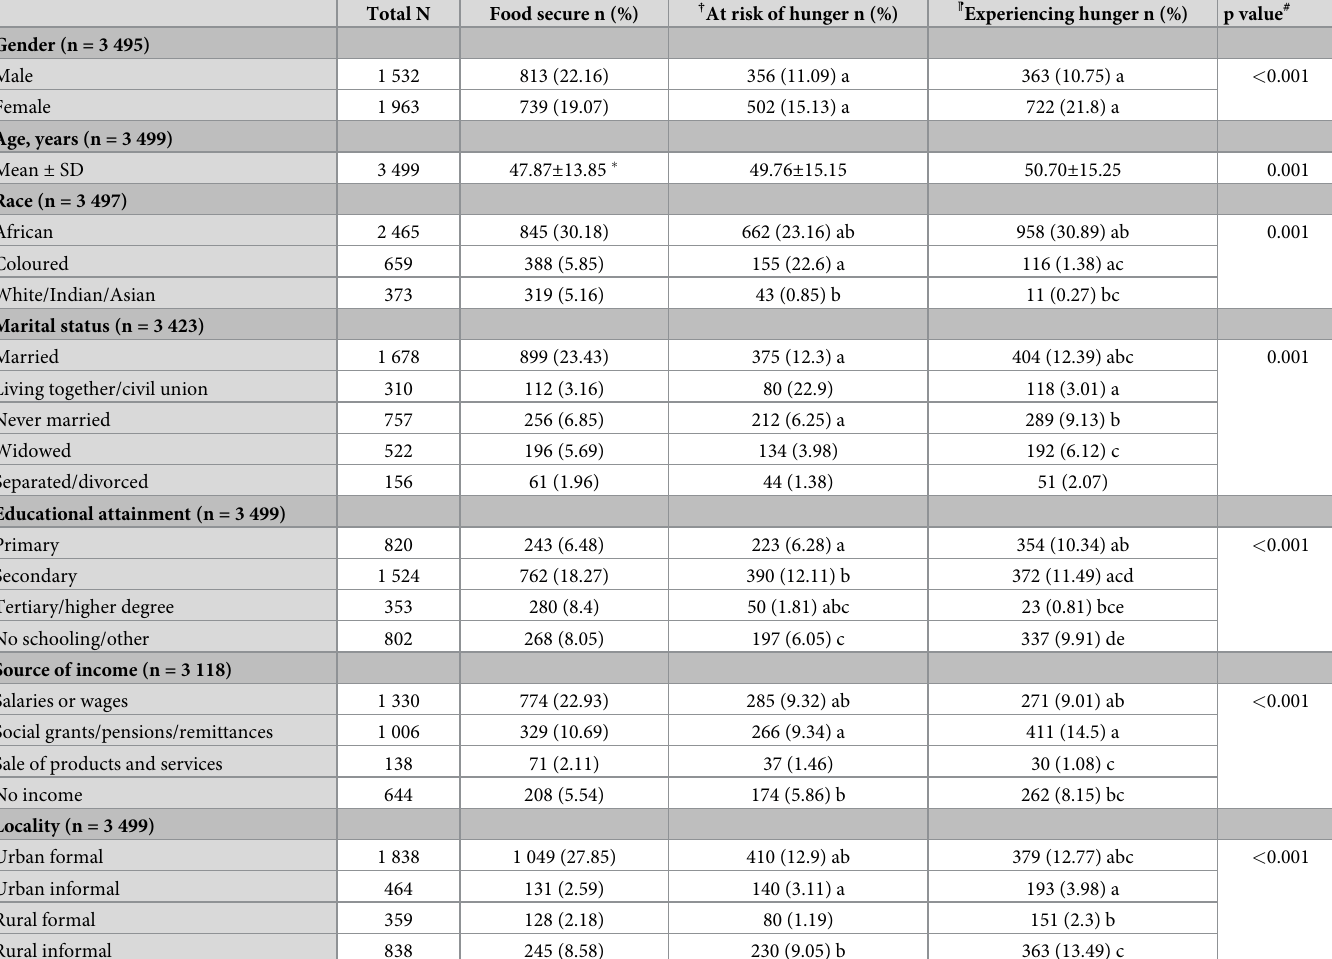
Table 2. Weighted prevalence of household food security, stratified by sociodemographic characteristics of designated household heads of South African house- holds with children. Total N Food secure n